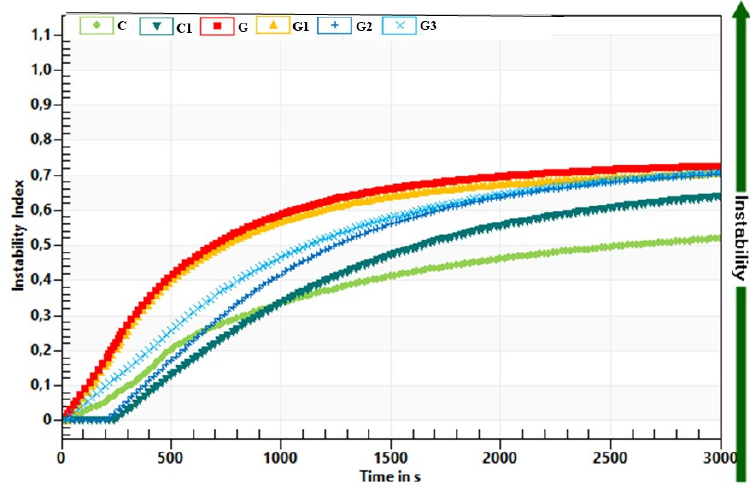
Figure 7. Influence of green tea and inulin addition yoghurt instability index. The abbreviations in the figure refer to the control sample (C), control yoghurt with 6% inulin (C1), yoghurt with green tea (G), yoghurt with green tea and 3% inulin (G1), yoghurt with green tea and 6% inulin (G2), yoghurt with green tea and 9% inulin (G3).